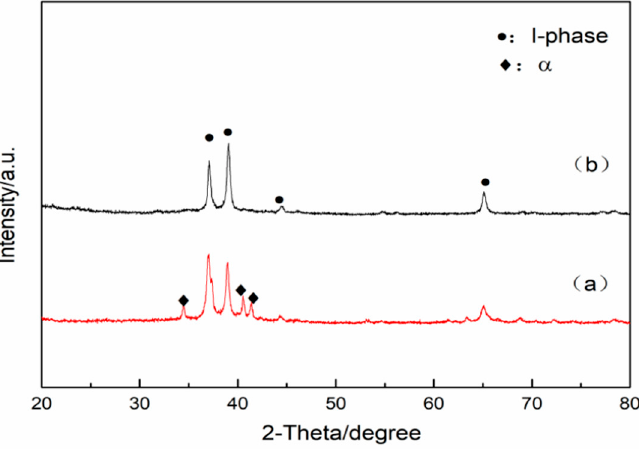
Figure 1. XRD patterns of ( a ) The Ti 40 Zr 40 Ni 20 rod and ( b ) The Ti 40 Zr 40 Ni 20 ribbons.